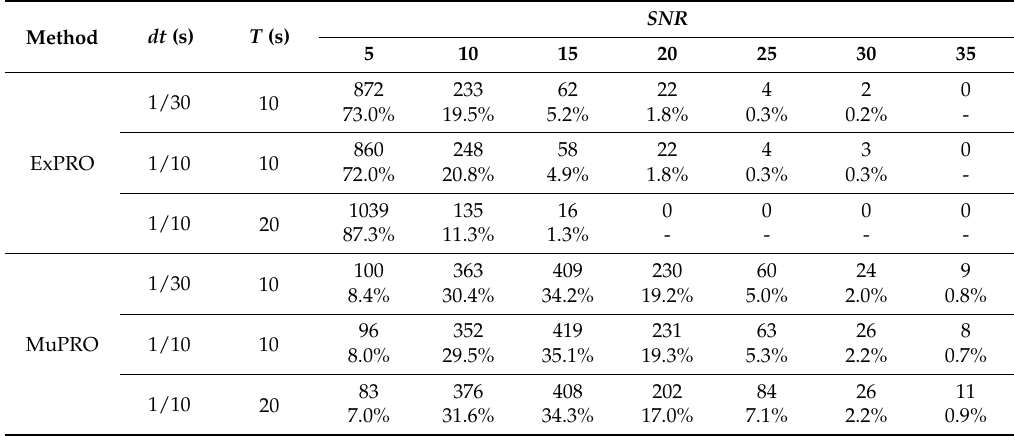
Table 7. SNR Number (shift time = 1.0 s, time = 40 min).